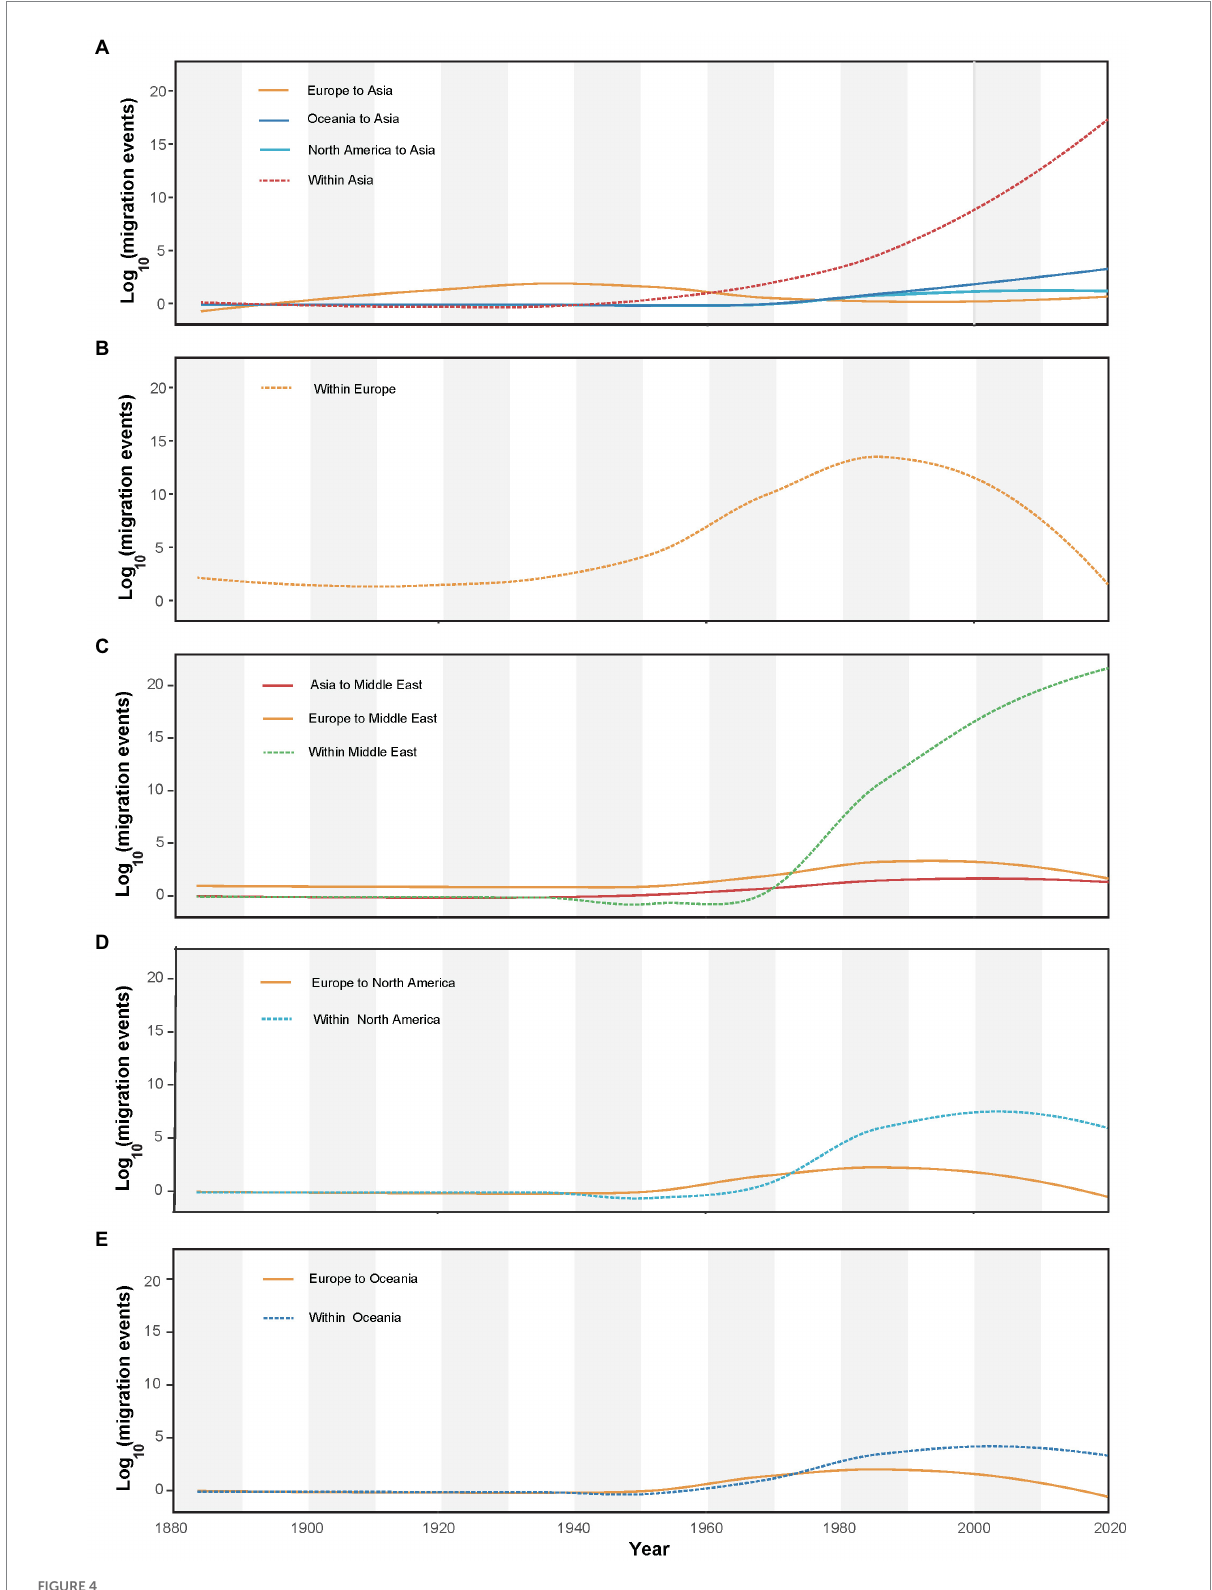
FIGURE 4 Inferred migration events (on log 10 scale) of alfalfa mosaic virus through time (year). The plots also show within-region migration over time for (A) Asia, (B) Europe, (C) Middle East, (D) North America, and (E)